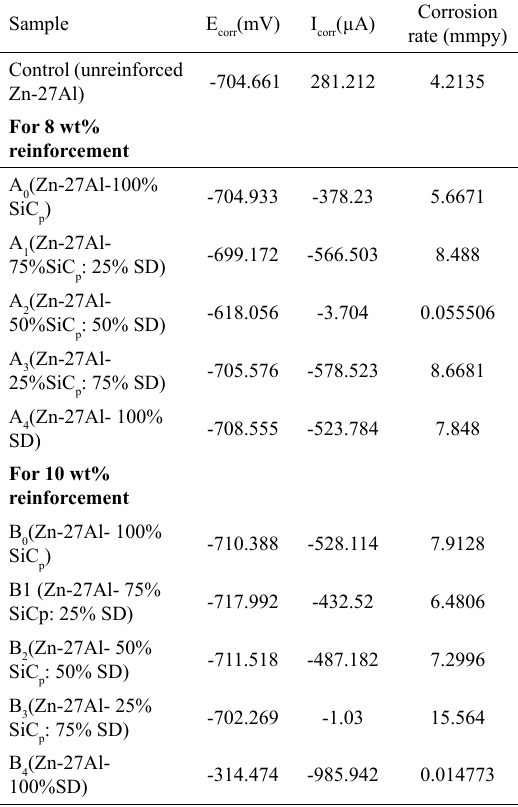
Table 3. Electrochemical data of the unreinforced and reinforced ZA-27 alloy composites from the tafel extrapolations in 0.3M H SO 2 4